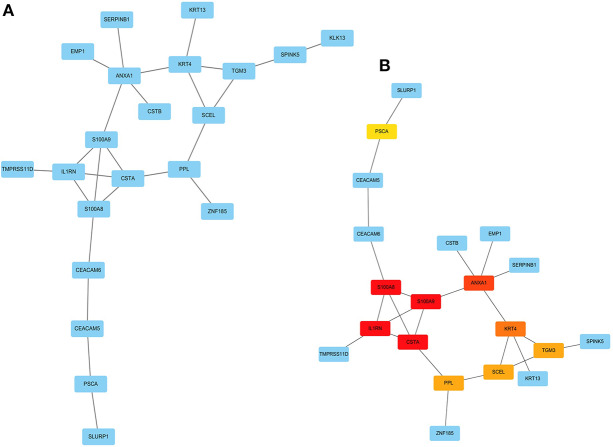
Visualization of the protein-protein interaction (PPI) network and the candidate hub genes. (A) PPI network of the genes between DEG lists and two co-expression modules. The blue nodes represent the genes. Edges indicate interaction associations between nodes. (B) Identification of the hub genes from the PPI network using maximal clique centrality (MCC) algorithm. Edges represent the protein-protein associations. The red nodes represent genes with a high MCC sores, while the yellow node represent genes with a low MCC sore.